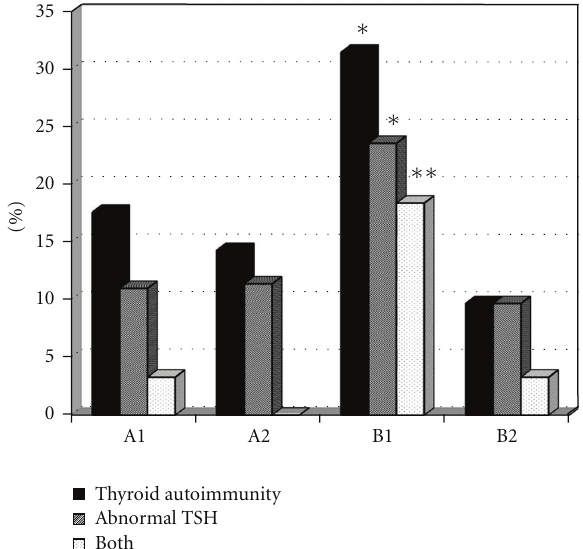
Figure 1: Patients (as percentages within each single group) a ff ected by thyroid autoimmunity (TPO-Ab, Tg-Ab, and TSHr-Ab positivity), thyroid dysfunction (TSH < 0.4mIU/L or > 4.2mIU/L) or the combination. Group A1: GDM pregnant women; group A2: non-GDM pregnant women; group B1: post-GDM women; group B2: healthy mothers. ∗ P < 0 . 05 versus groups A1 and B2; ∗∗ P < 0 . 05 versus group B2 and P < 0 . 001 versus group A1.